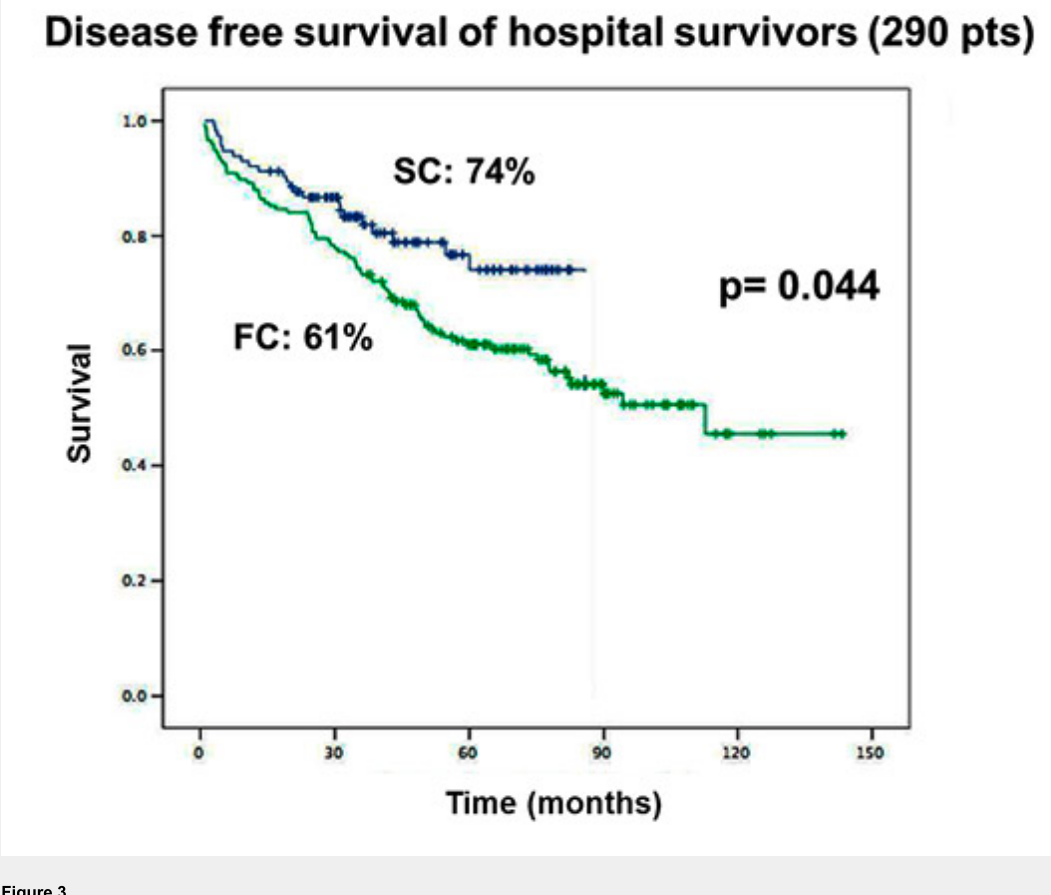
Figure 3 Disease free survival of hospital survivors (290 patients); SC: blue; FC: